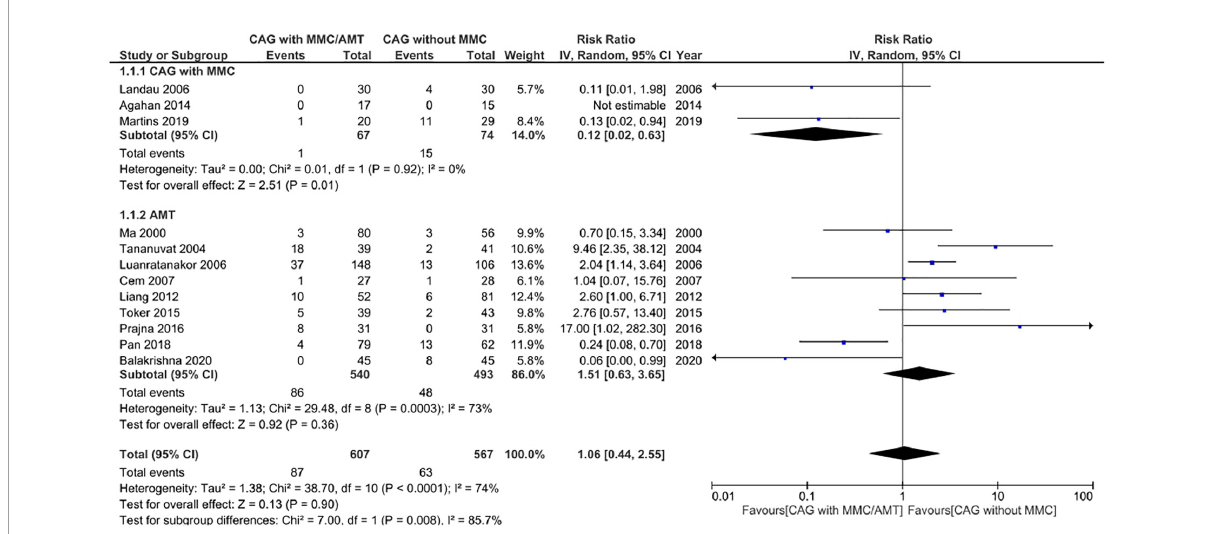
FIGURE5 Forrest plot of rate of recurrence. CI, confidence interval; IV, inverse variance; CAG, conjunctival autograft; AMT, amniotic membrane transplantation; MMC, mitomycin C.